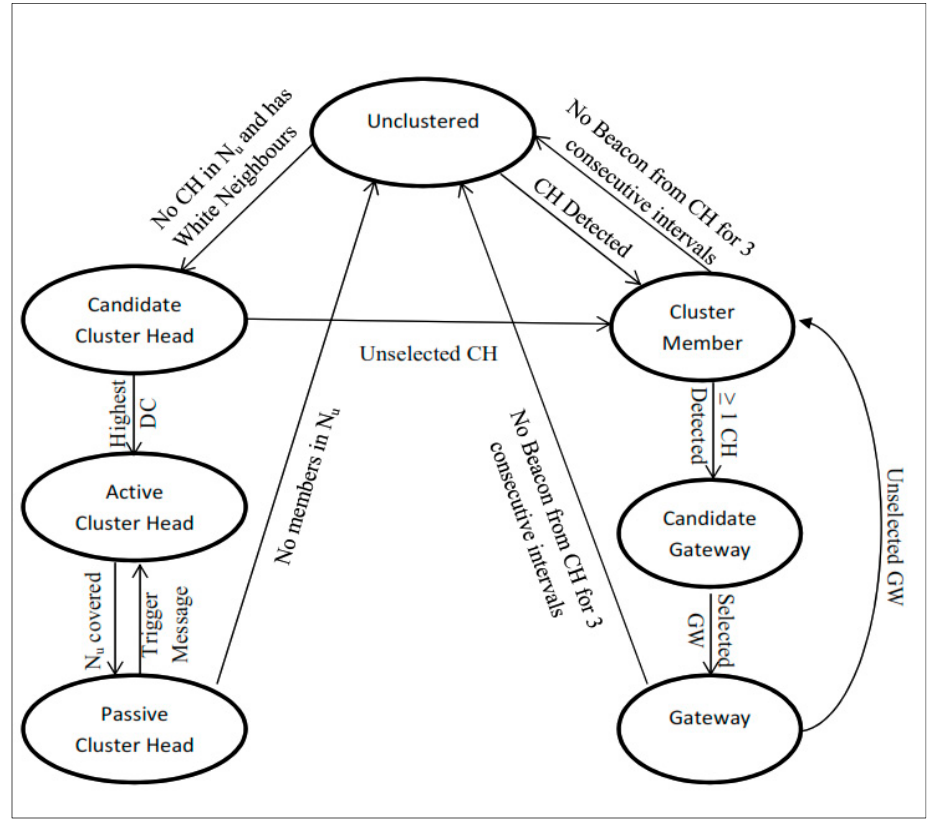
Figure 4. State transition in vehicles.